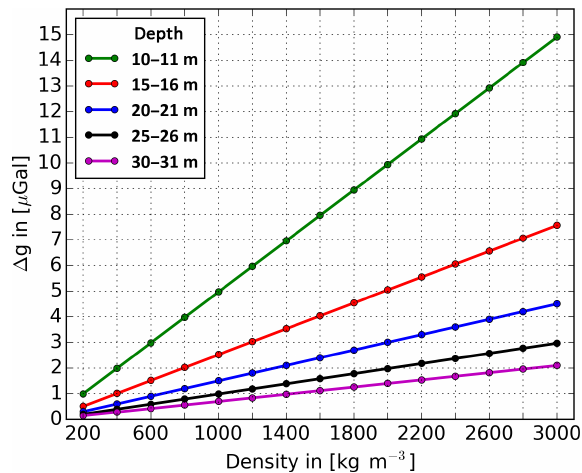
Figure 11. Expected changes in gravity against density for a 1m thick dissolved layer located beneath a survey point and at differ- ent depths, with a spatial dimension of d x = 10m, d y = 10m, and d z =